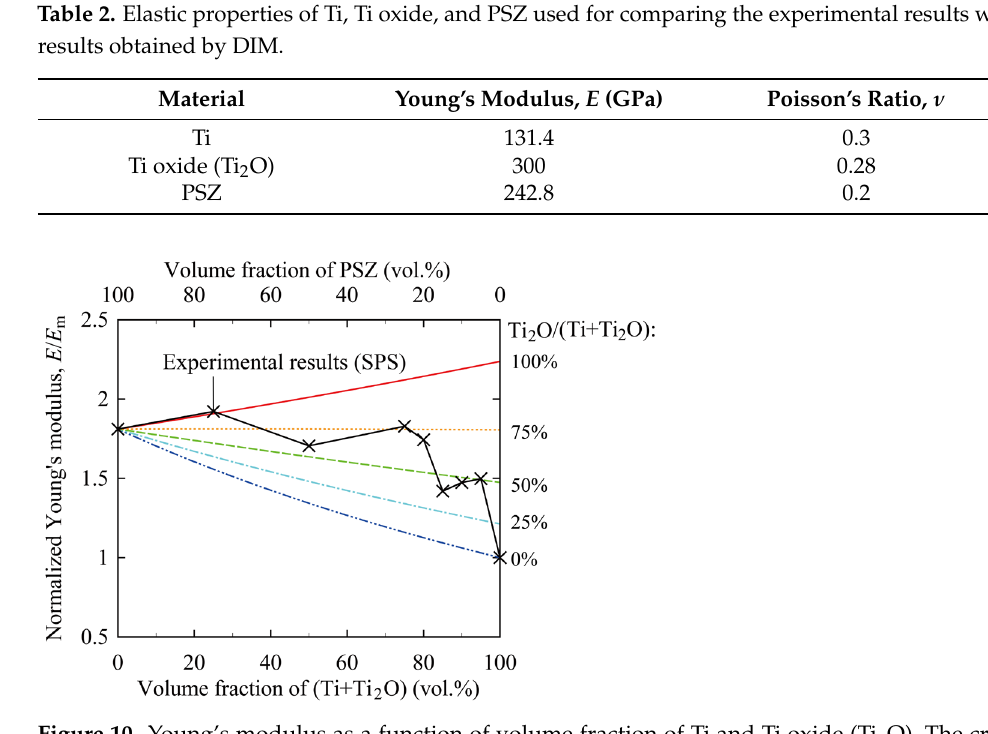
Figure 10. Young’s modulus as a function of volume fraction of Ti and Ti oxide (Ti 2 O). The cross marks denote the experimental results for the PSZ-Ti composites fabricated via SPS.